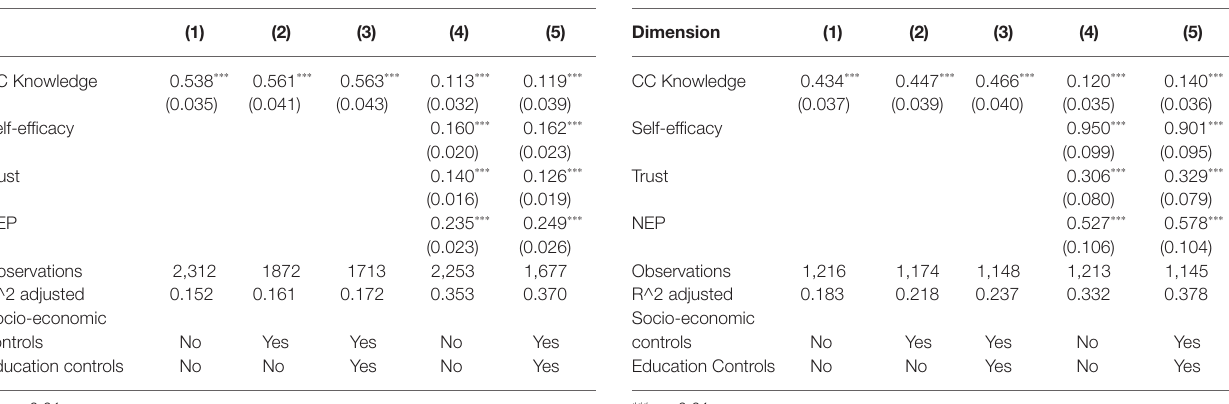
TABLE 6 | Results PCA